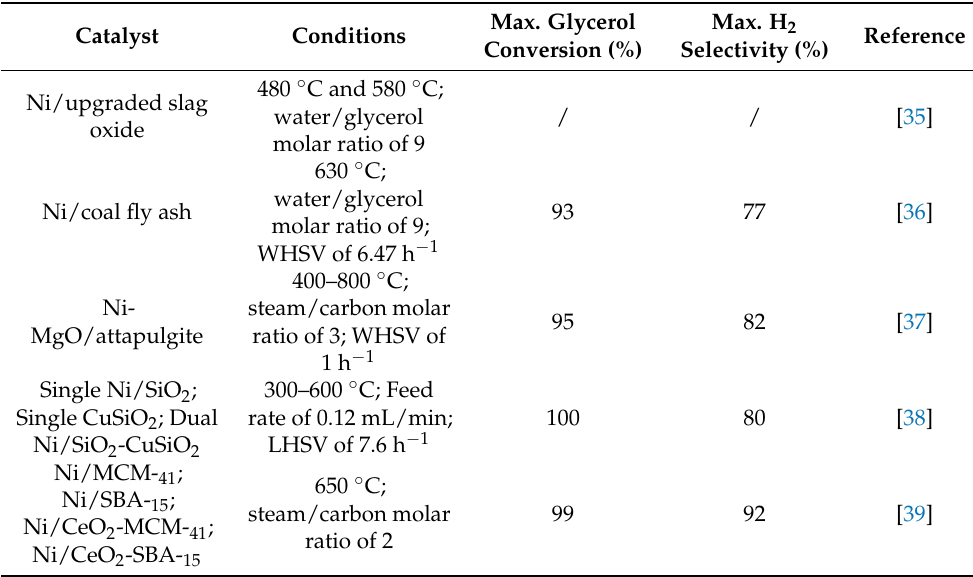
Table 2. Recent investigations on glycerol conversion for producing H 2 via steam reforming over transition metal-based